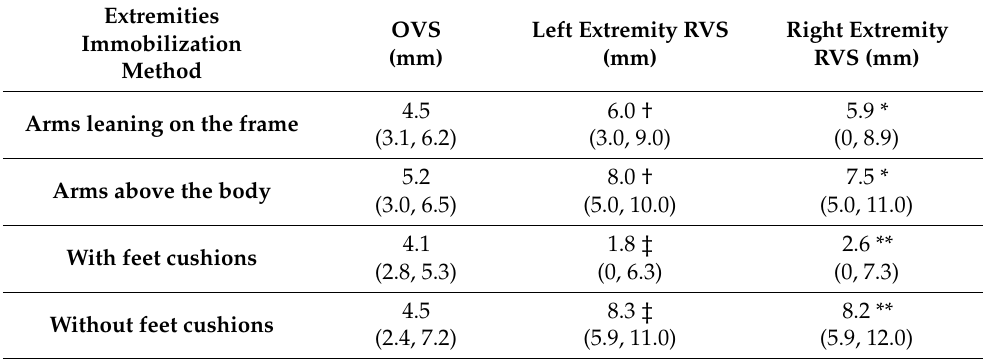
Table 3. Median values of the OVS between CBCT-CT and the RVS for the extremities, grouped by immobilization method. IQR values are reported in